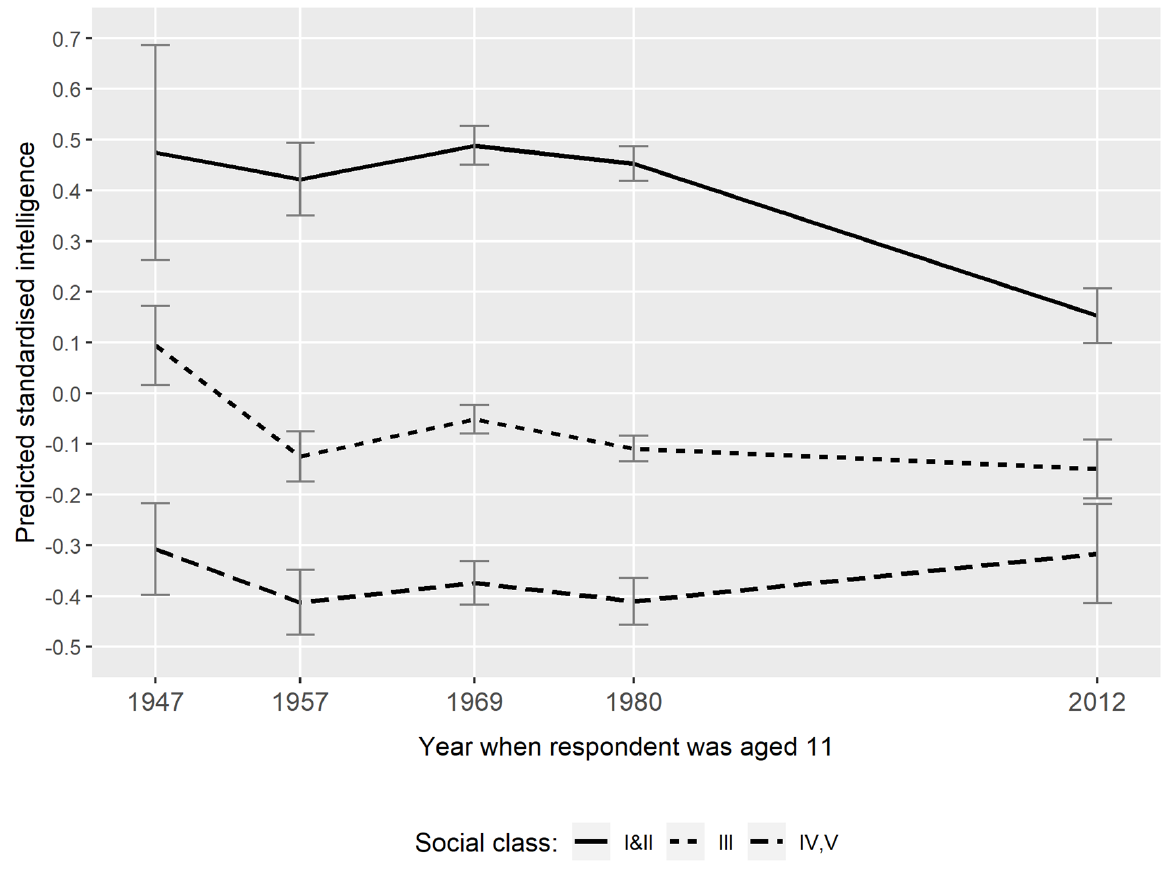
Figure 1: Predicted mean intelligence, by class and year. Error bars are 95 percent confidence intervals for individual points. Source: Table